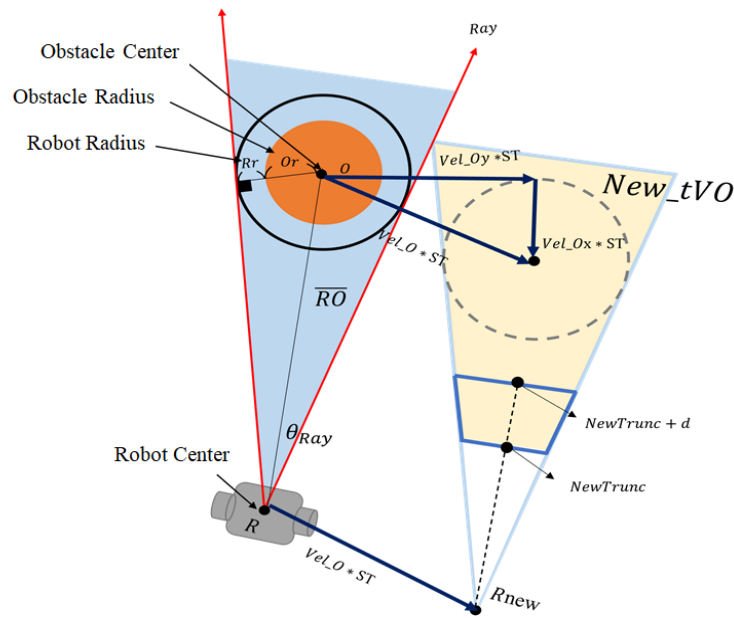
Figure 13. The final velocity obstacle layer.